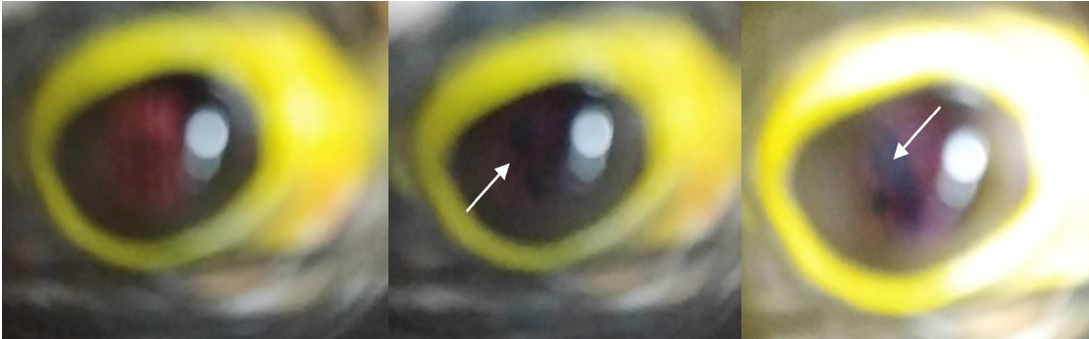
Figure 5. Fundus of a hobby falcon ( Falco subbuteo ) showing an anomaly of the pecten (white arrow). A degenerative process secondary to eye trauma was suspected. This fundus examination was classified as acceptable as fundus components were identified, but the examination was not totally satisfactory because of blur and light reflection.